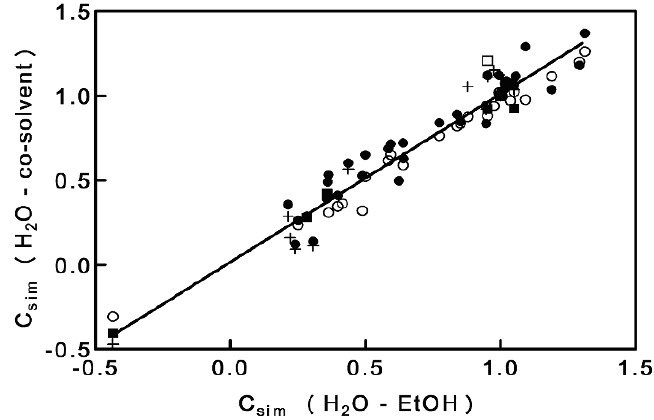
Figure 2. Similarity coefficients, C , for reactions in other five water-organic mixtures plotted against the similarities for water-ethanol solvent sim system. ○ - water-methanol; ● - water-acetone; +- water-1,4-dioxane; ■ -water-acetonitrile; □ - water-DMSO.